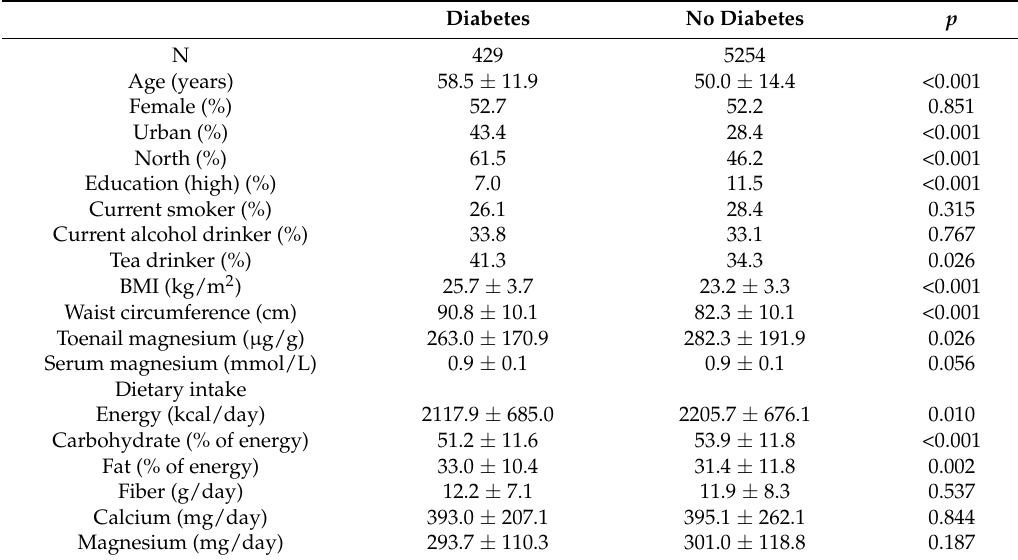
Table 1. Characteristics of the study population by diabetes status